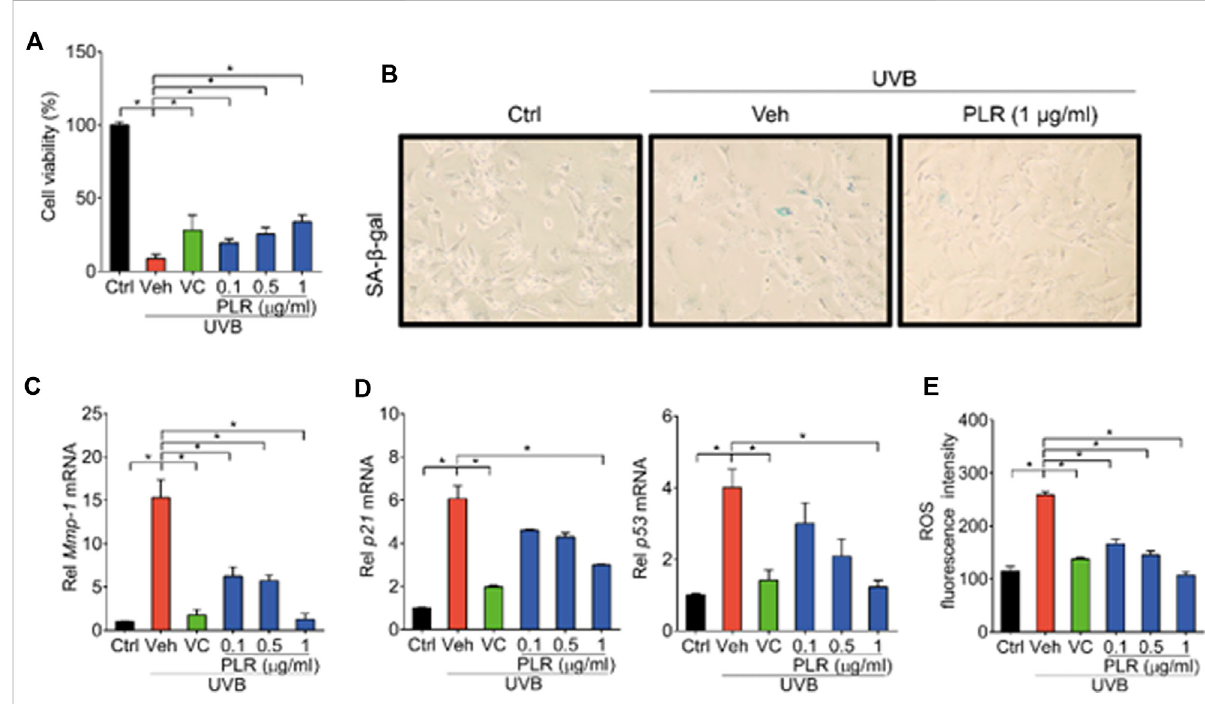
FIGURE 3 PLR shows dose-dependent protective effects on UVB-induced cell senescence. L929 cells were subjected to UVB irradiation (100 mJ/cm 2 ) with or without VC (6 μ g/ml) or various concentrations of PLR extract (0.1, 0.5 or 1 μ g/ml). (A) Effects of PLR treatment on the viability of L929 cells. (B) RepresentativeimagesofSA- β -galstaining. (C,D) Expressionlevelsof Mmp-1/p21/p53 mRNAinL929cells. (E) ROSlevelsmeasuredbyDCFH-DA staining. Data are presented as mean ± SD ( n = 3). * p < 0.05. Ctrl, control; Veh,